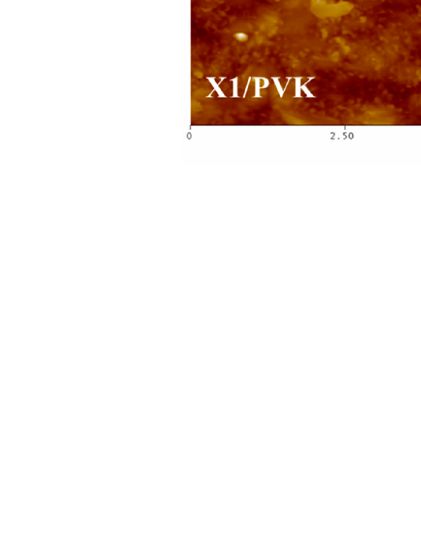
Figure 7. AFM images of ( a ) spiro-OMeTAD; ( b ) X1 ; and ( c ) X2 on perovskite film .